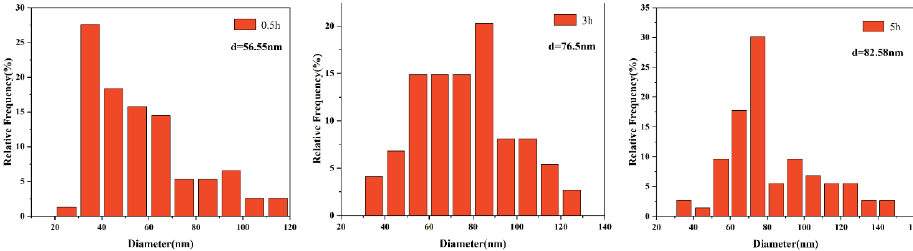
Figure 9. The distribution of TiN precipitates size after different holding time at the austenitizing temperature of 1050 °C.